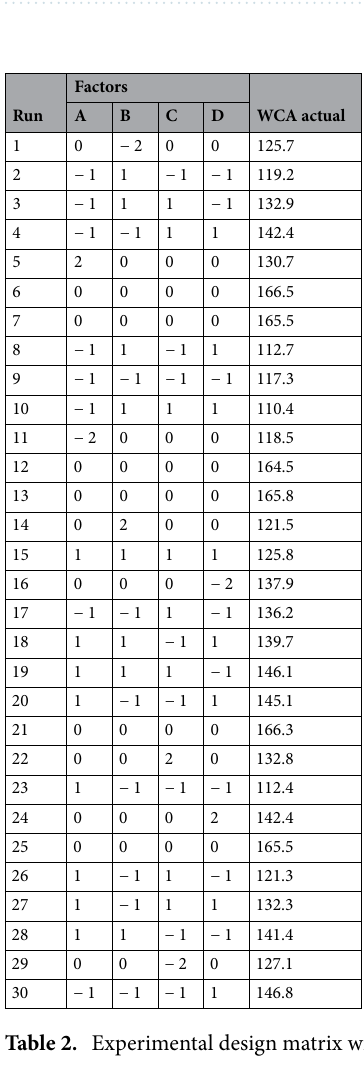
Table 1. Actual levels and coded reaction parameters.